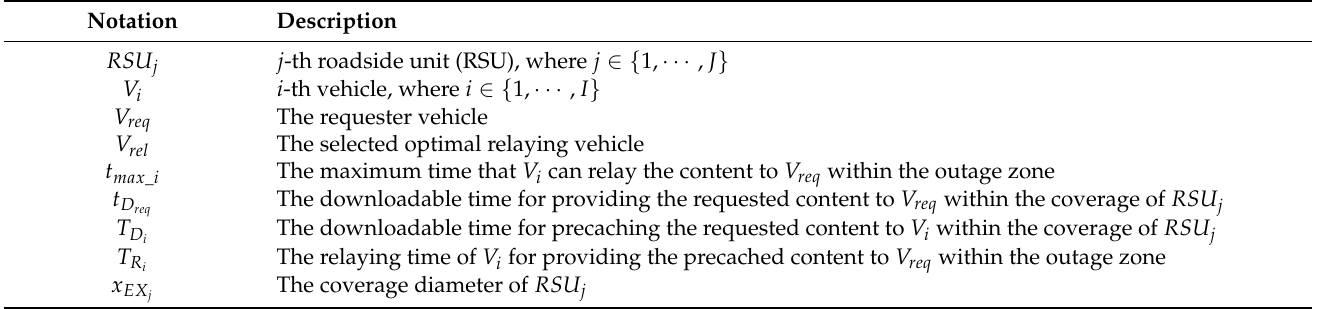
Table 1. Notations for selecting the optimal relaying